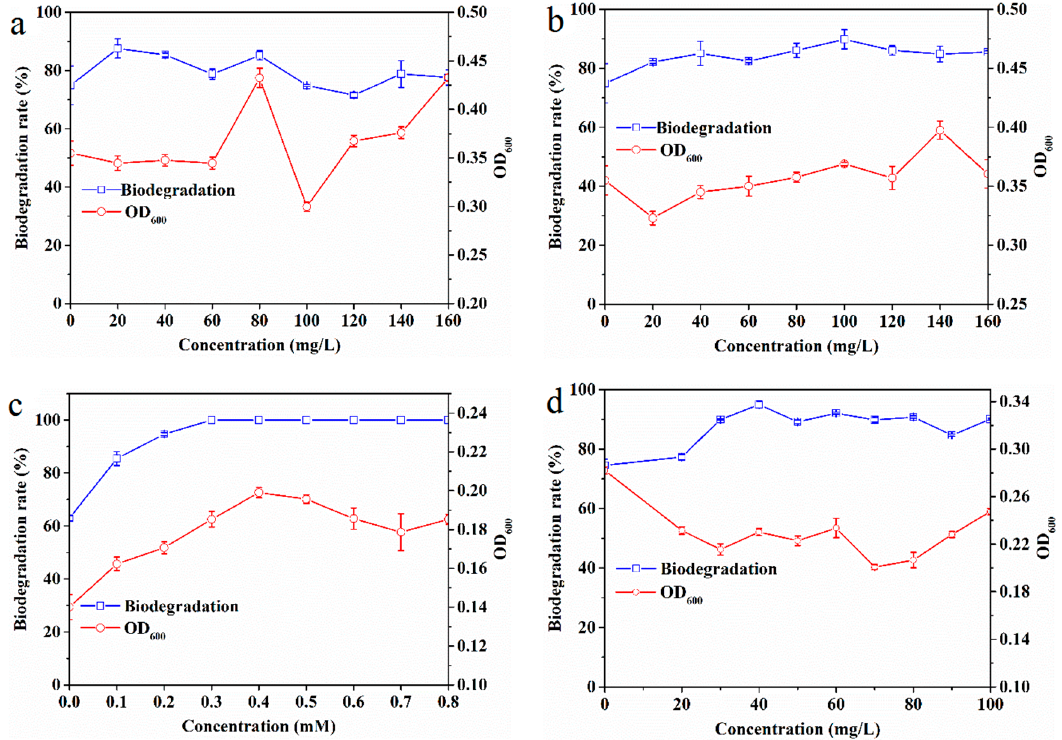
Figure 4. Effects of ( a ) glucose, ( b ) yeast extract, ( c ) sodium lactate, and ( d ) rhamnolipid on EDB biodegradation at 25 °C.